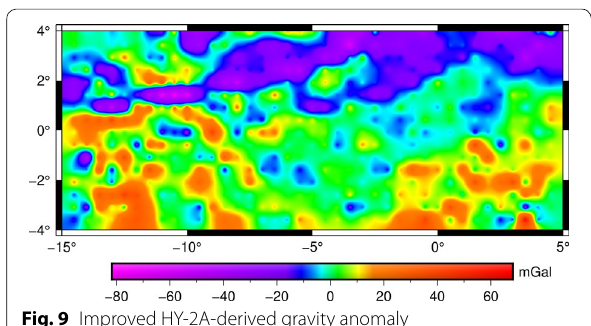
Fig. 9 Improved HY-2A-derived gravity anomaly